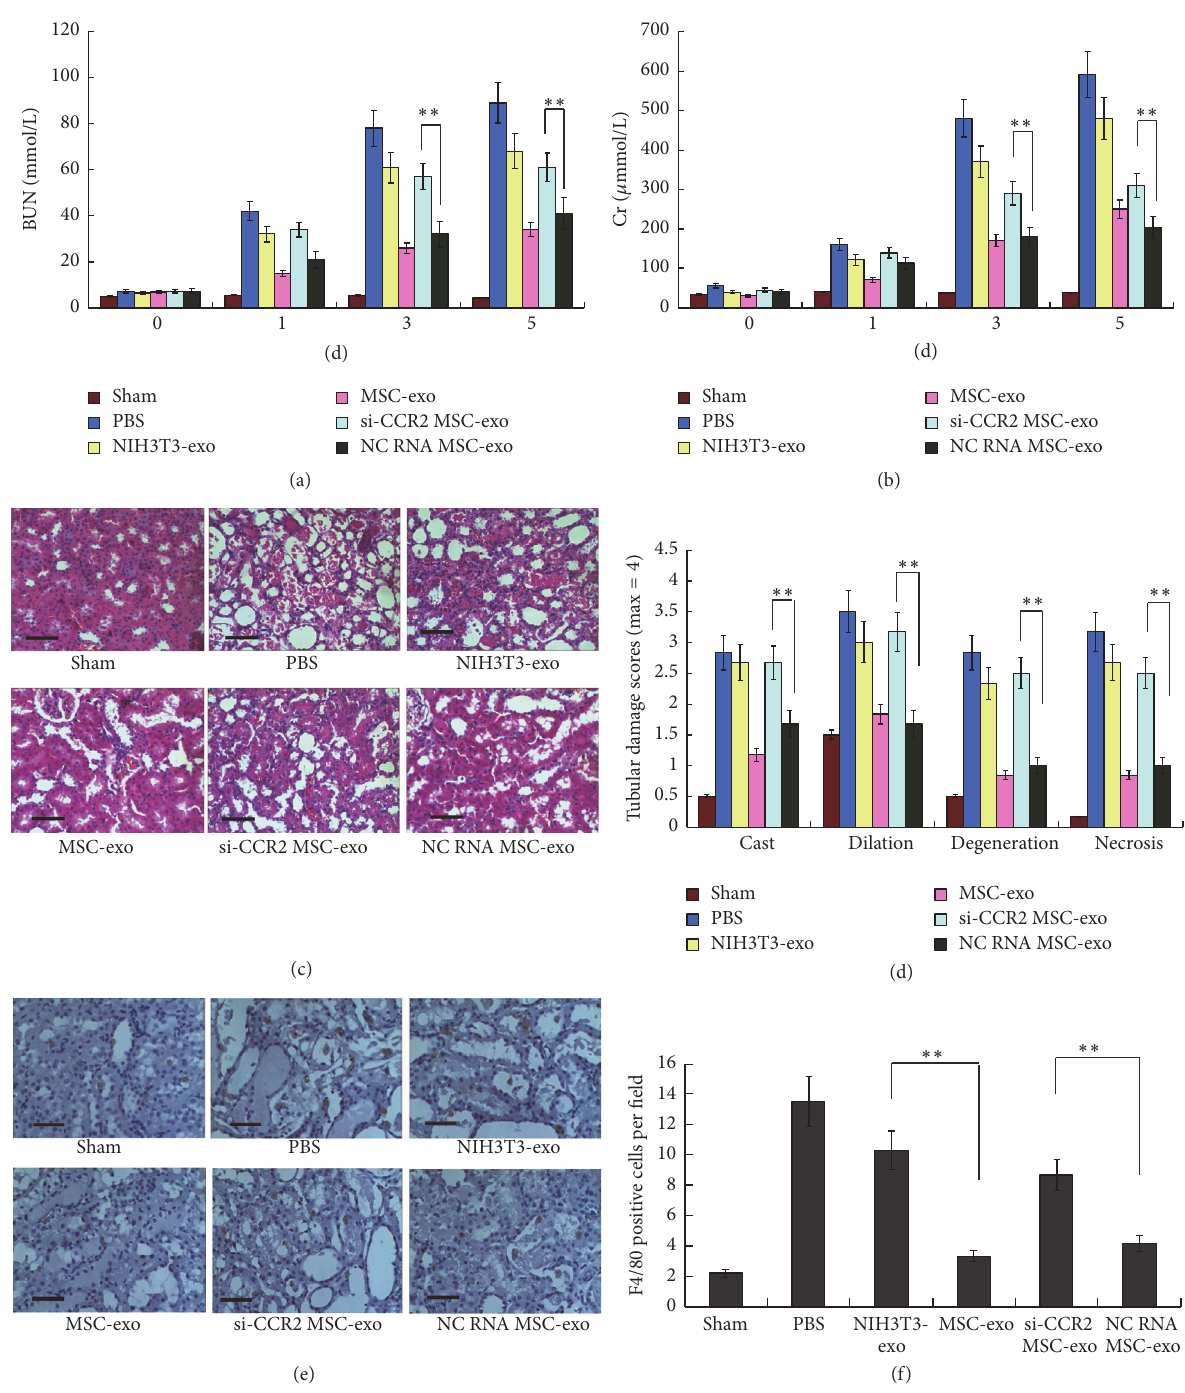
Figure 4: CCR2-positive MSC-derived exosomes reduce ischemia/reperfusion-induced renal injury. Babl/c mice were anesthetized and the ischemia/reperfusion operation was performed by clamping the renal vessels for 60 mins. A sham operation was also performed without renal vessels clamping. At 10min after the surgery, mice received a renal capsule injection of 200 𝜇 g of exosomes per kidney or only PBS as a control. (a)-(b) Blood urea nitrogen (BUN) and creatinine (Cr) values from 0 days to 5 days. Bars represent standard error of the mean ± SD from three repeats. (c)-(d) Representative micrographs of renal histology at day 5 were shown (c). Scale bars, 100 𝜇 m. Morphologic findings were also scored according to cast deposition (cast), tubular dilation (dilation), tubular degeneration (degeneration), and tubular necrosis (necrosis), and the average scores for each group were shown as mean ± SD from six repeats (d). (e)-(f) Representative micrographs of F4/80 staining of mice kidney section at day 5 were shown (e), scale bars, 50 𝜇 m. The counts of positive cells per field were also shown as the mean ± SD from six repeats (f). All the significance was determined by ANOVA and Student’s 𝑡 -test. ∗∗ 𝑃 < 0.01 . Exos: exosomes; si-CCR2 MSC-exo: exosomes derived from CCR2 siRNAs-transfected MSCs; NC RNA MSC-exo: exosomes derived from negative control RNA-transfected